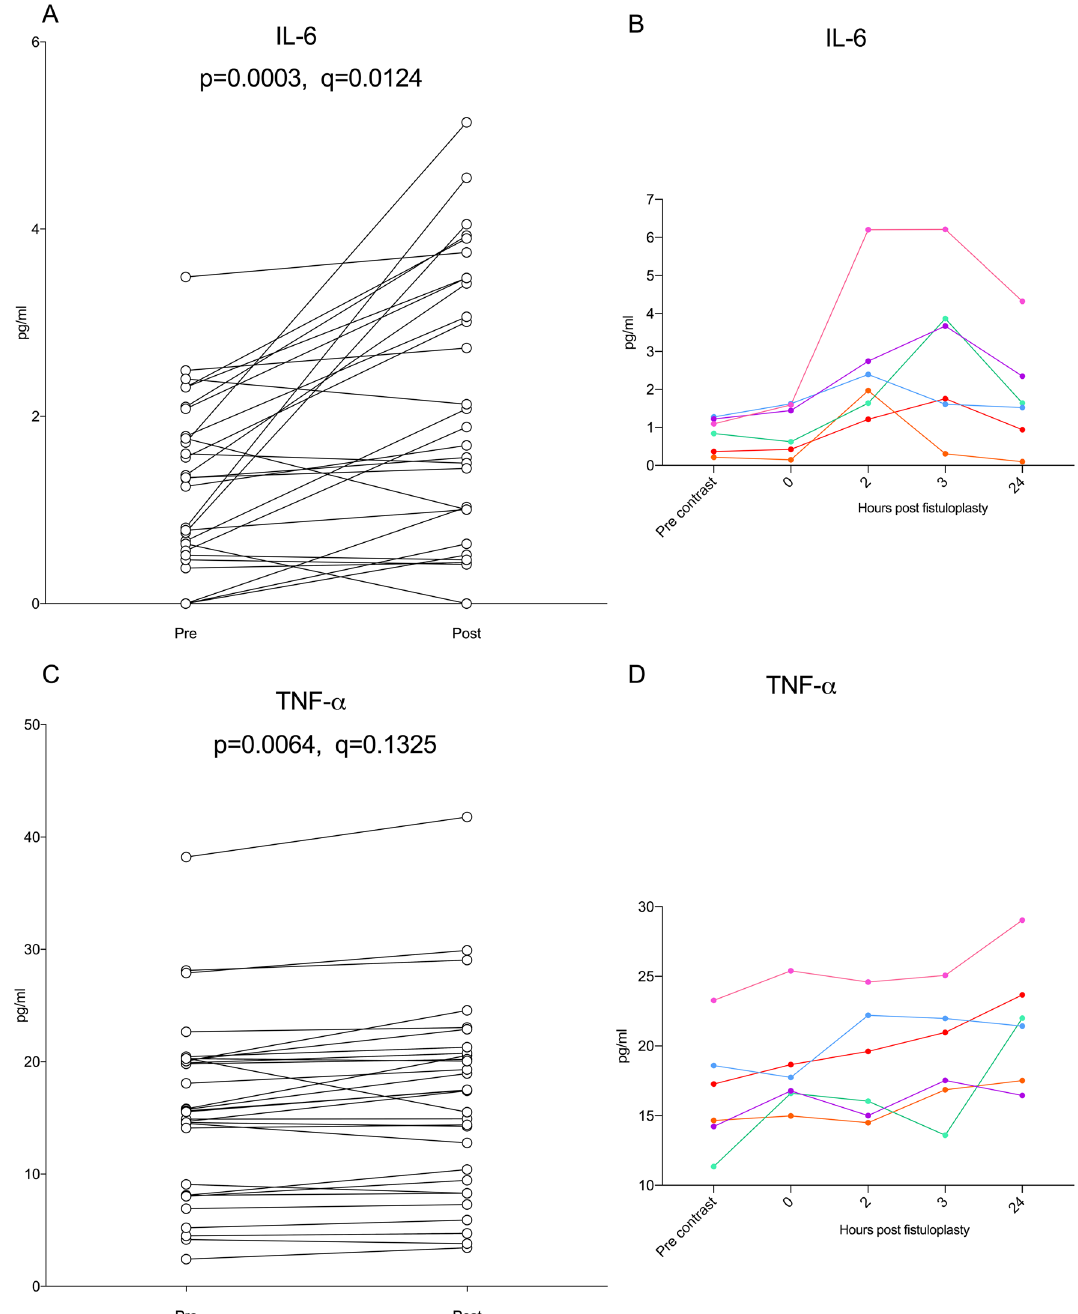
Figure 4. IL-6 and TNF-α following a fistuloplasty procedure. ( A ) IL-6 levels in paired patient plasma samples before and 1–2 days after their fistuloplasty. n = 30 paired samples. Data was analysed using a paired t test. ( B ) Plasma protein levels of IL-6 through the course of the fistuloplasty procedure. n = 6 patients. ( C ) TNF-α levels in paired patient plasma samples before and 1–2 days after their fistuloplasty. n = 30 paired samples. ( D ) Plasma protein levels of TNF-α through the course of the fistuloplasty procedure. n = 6